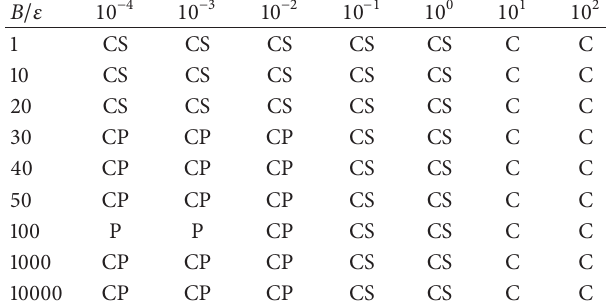
Table 2: Behavior of solutions without diffusion ( ] =0) for different values of the viscoelastic characteristic time, 𝜀 (rows), and the temperature gradient, B (columns). We introduce the following notation to account for the obtained numerical results: “C” denotes a fully chaotic behavior, “CS” a transition from chaotic outburst to stable equilibria, “P” a stable periodic orbit, and “CP” a transitional behavior from chaotic to periodic.